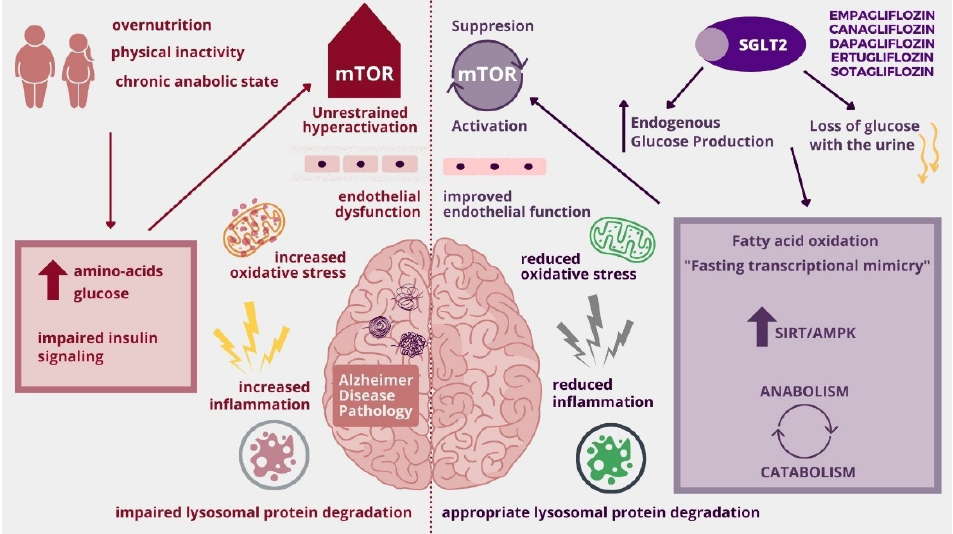
Figure 3. Influence of SGLT2 inhibitors on unrestrained activation of mTOR (mechanistic/mammalian target of rapamycin). AMPK-AMP-activated protein kinase,